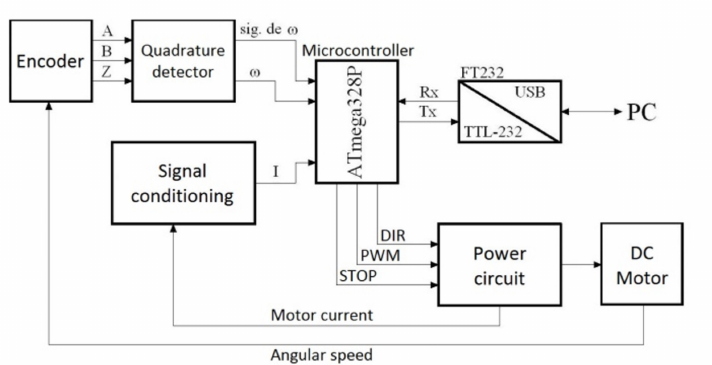
Figure 12. Schematic diagram of the interface circuit between the PC and the power stage.